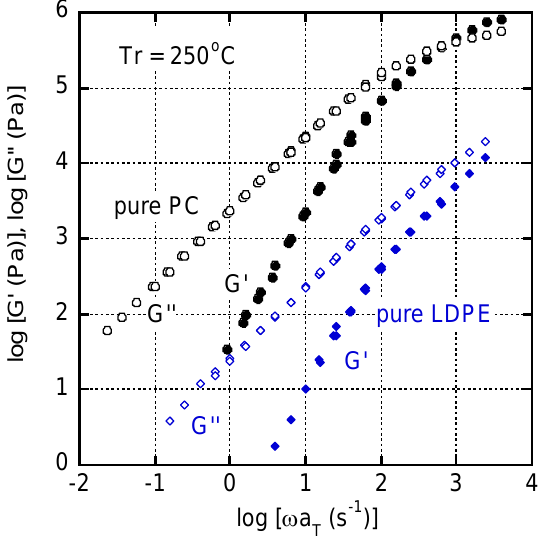
Figure 2. Master curves of oscillatory shear moduli such as the storage modulus G ′ (closed symbols) and loss modulus G” (open symbols) at 250 °C for PC (circles) and LDPE (diamonds). Both polymers showed the rheological terminal region in the low-frequency region. , steady-state compliance 0